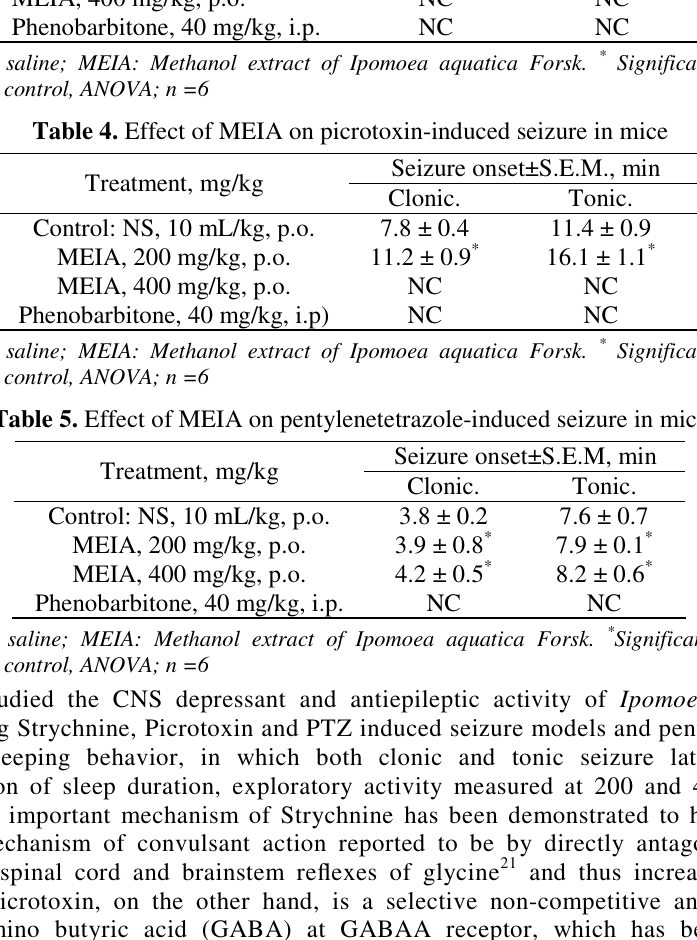
Table 3. Effect of MEIA on strychnine-induced seizure in mice Treatment, mg/kg Control: NS, 10 mL/kg, p.o. MEIA, 200 mg/kg, p.o. MEIA, 400 mg/kg, p.o.